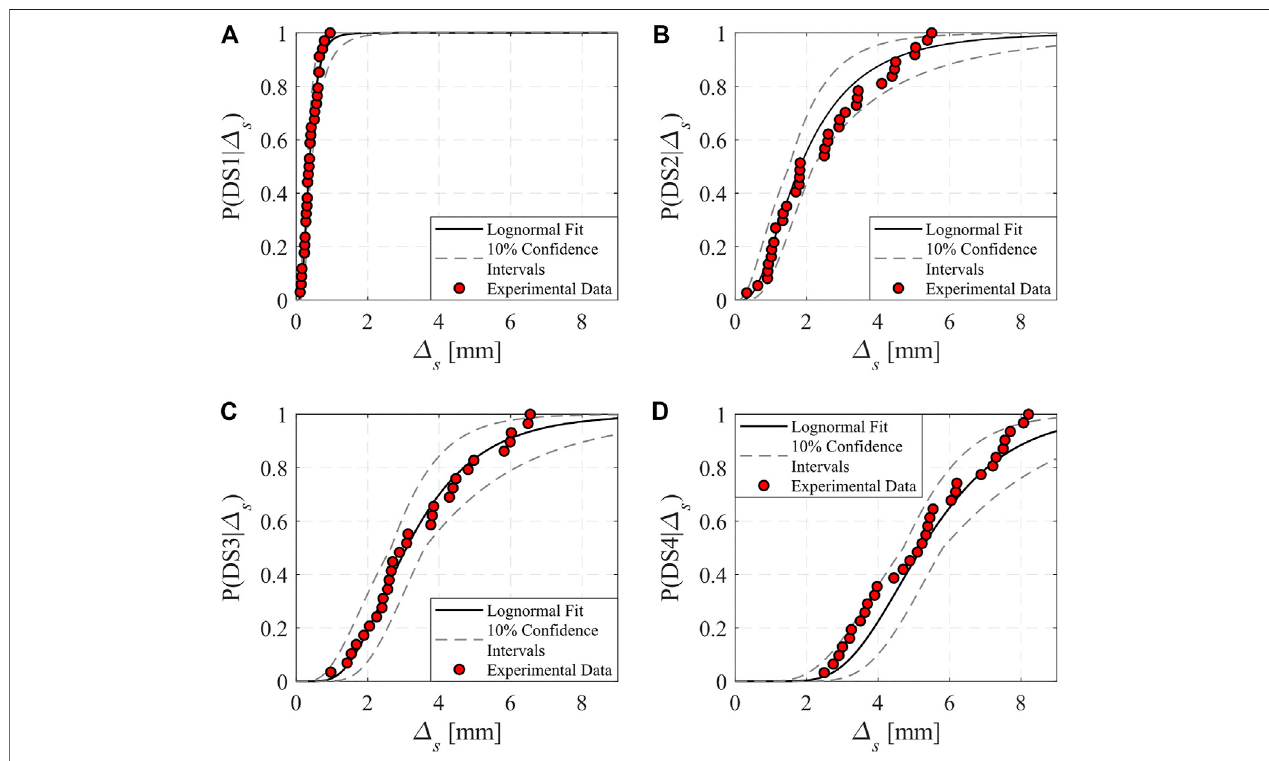
FIGURE 6 | Envelope of epistemic uncertainties on fragility functions of steel beam-slab connections derived from the full dataset. (A) DS1 (B) DS2 (C) DS3 and (D) DS4.